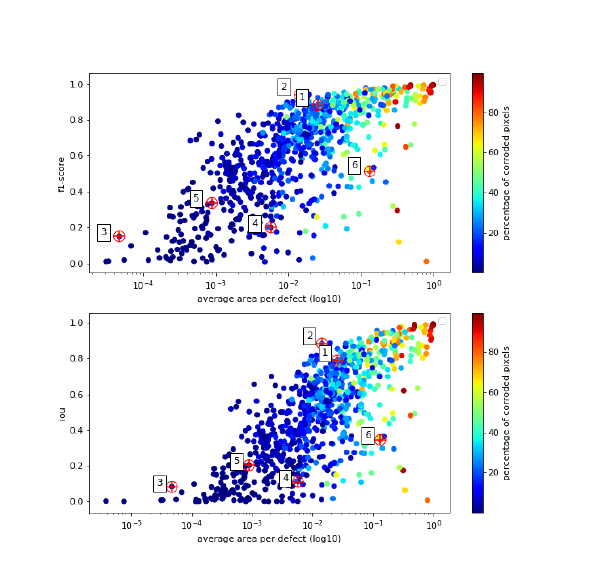
Figure 8. f1-score (above) and IoU (below) versus the percentage of true corroded pixels